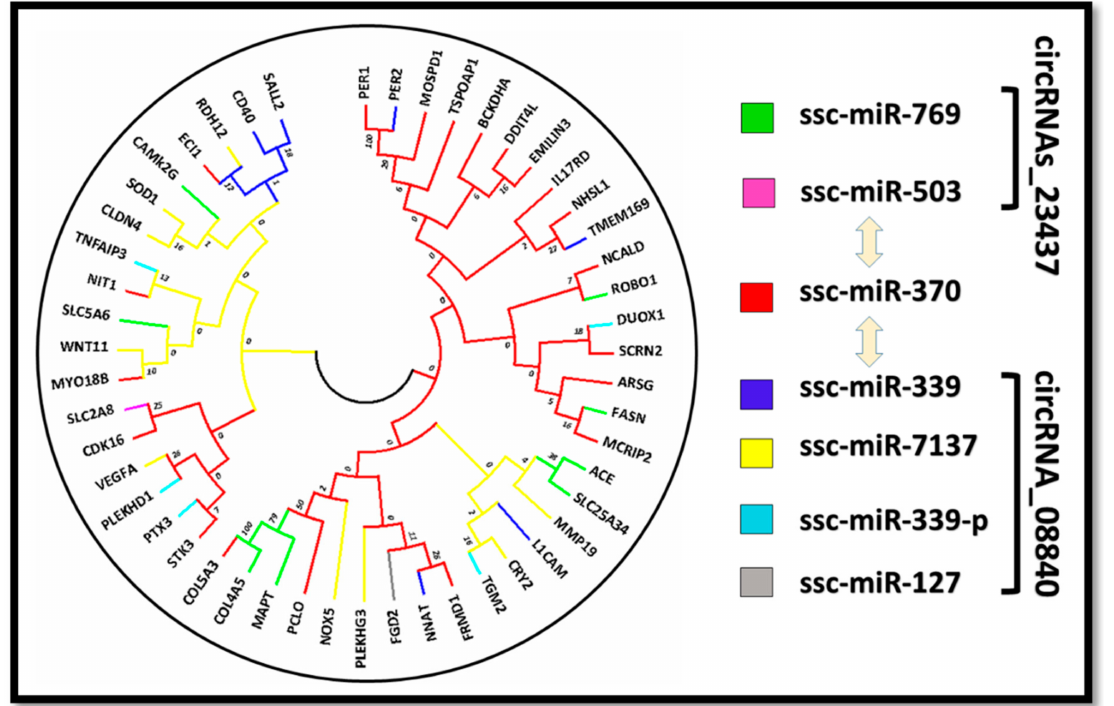
Figure 8. Two rooted phylogenetic trees constructed with the neighbor-joining method. Bootstrap values from 1000 replicates are indicated at each node of the tree. The tree shows various clades representing separate phylogenetic groups in each clade but similar genes in the same clade. Different colors in the tree represent the target genes of different miRNA. Ssc-miRNA-370 was found in both circRNAs as a common binding